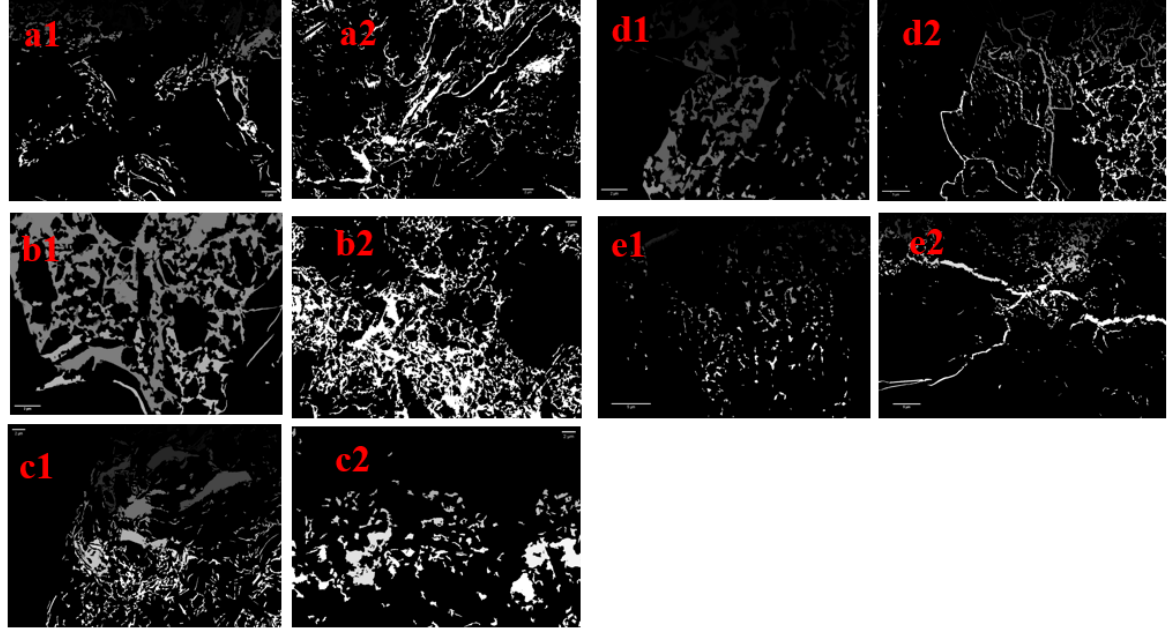
Figure 2. SEM images of shale after ImageJ treatment (( a1 ) 100 °C Before; ( a2 ) 100 °C After; ( b1 ) 200 °C Before; ( b2 ) 200 °C After; ( c1 ) 300 °C Before; ( c2 ) 300 °C After; ( d1 ) 400 °C Before; ( d2 ) 400 °C After; ( e1 ) 500 °C Before; ( e2 ) 500 °C After).